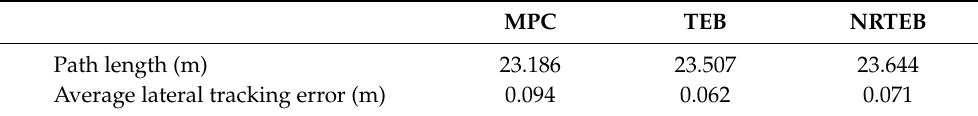
Table 3. Path length and average lateral tracking